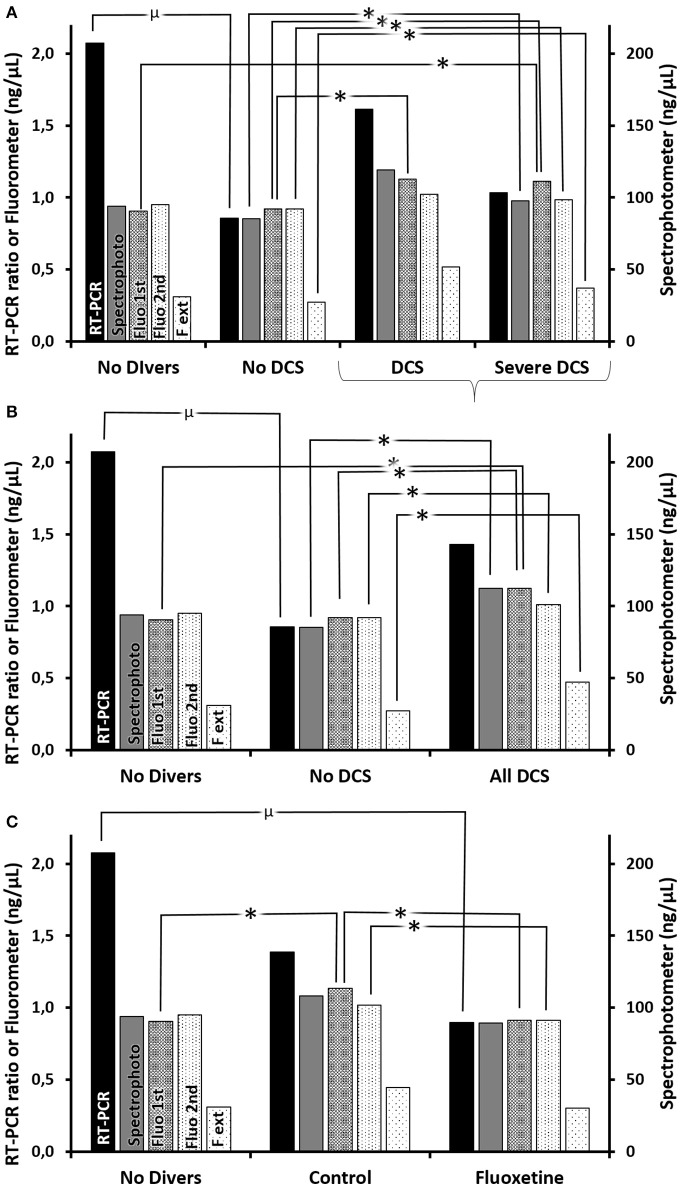
(A–C) Circulating oligonucleotides according to clinical status (A) with all DCS together (B) or according to treatment. (C) Quantifications of oligonucleotides were performed (1) by RT-PCR (black histograms) including double centrifuging before the extraction/purification phase, which was followed by a qPCR targeting mDNA and an internal standard (i.e., ratio), and which includes (2) (gray histograms) the measurement by spectrophotometry (nanodrop) post-extraction usually used to adjust the parameters of the qPCR, and (3) (histograms with dots) by direct fluorimetric measurement at the different stages (1st centrifuging → Fluo 1st, 2nd centrifugating → Fluo 2nd, extraction/amplification → F ext) targeting the double strands of DNA without distinction. *Significant difference, or μ a trend, in post-hoc analysis (p < 0.05) (see Supplementary Tables 4–6 for statistical details).